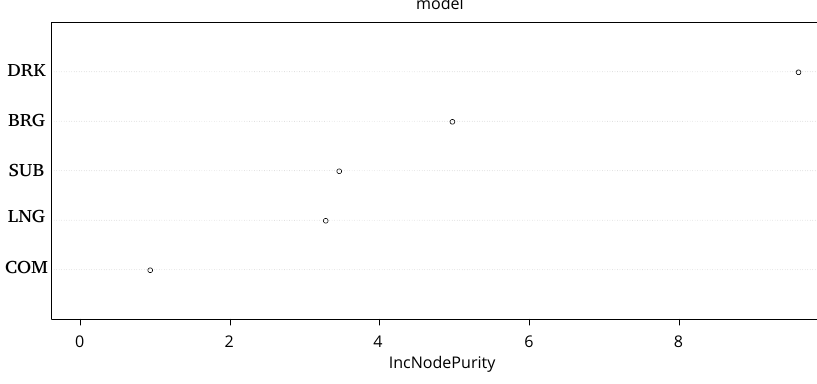
Figure 3: The variable importance plot